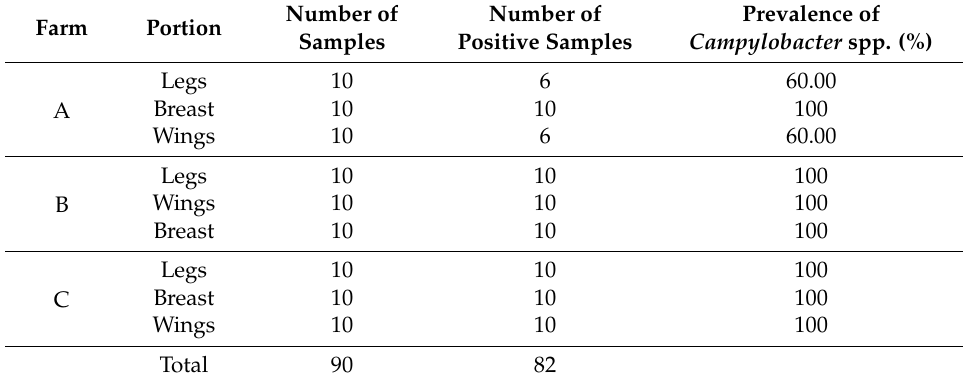
Table 3. Prevalence of Campylobacter spp. in poultry meat portions from the 3 farms at the processing plant